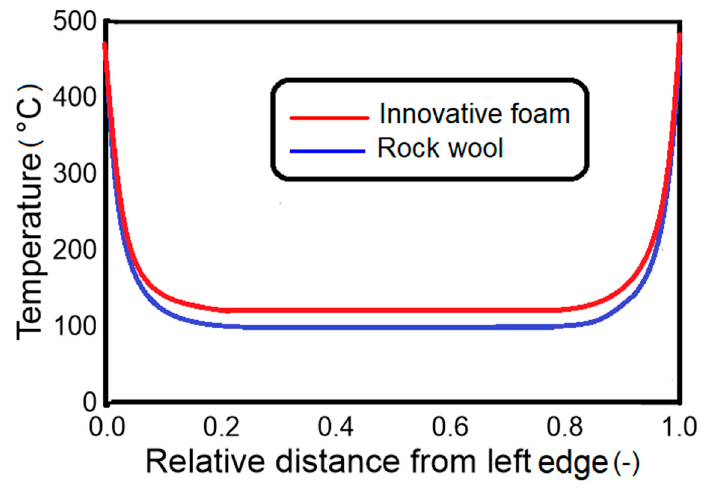
Figure 9. Transversal temperature profile at the final stage of the fire test (60 min) along the line passing through measuring point 5 (see black line in Figure 1b): comparison between foam and rock-wool model.